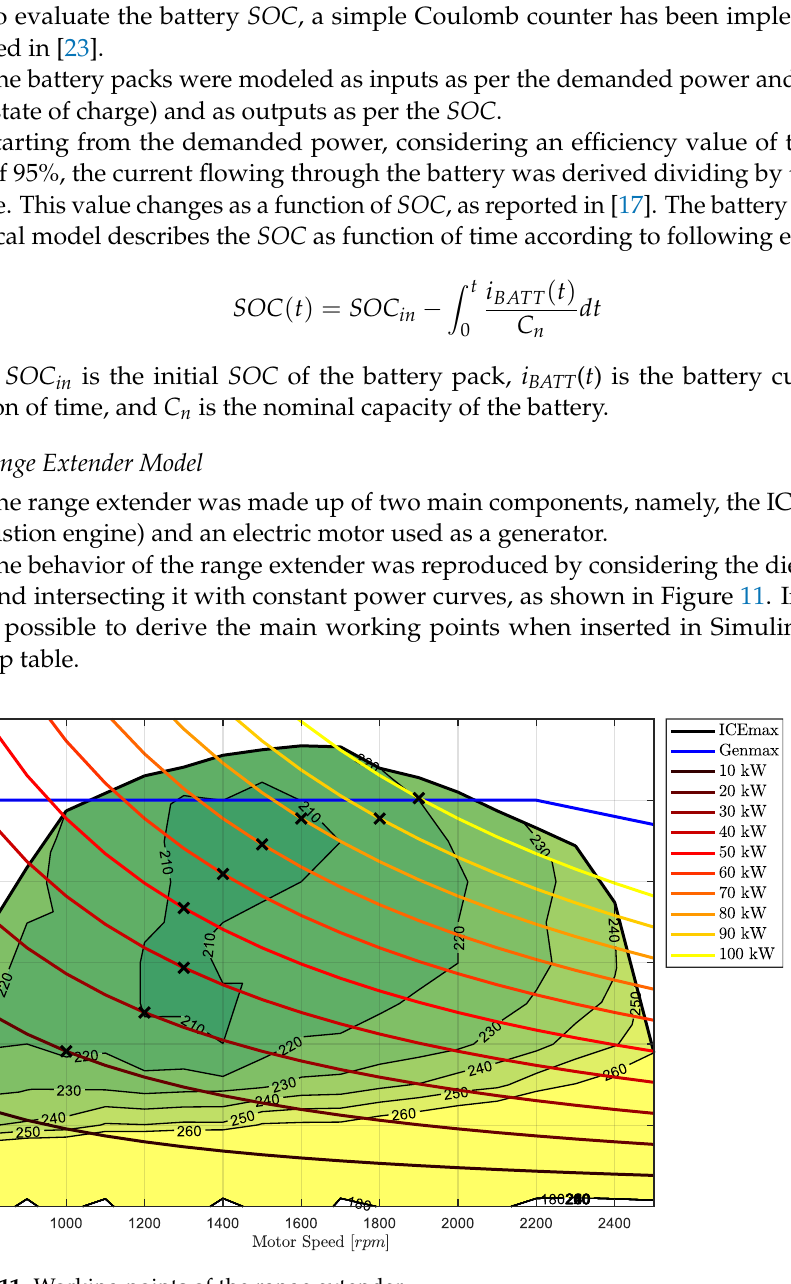
Figure 11. Working points of the range extender.